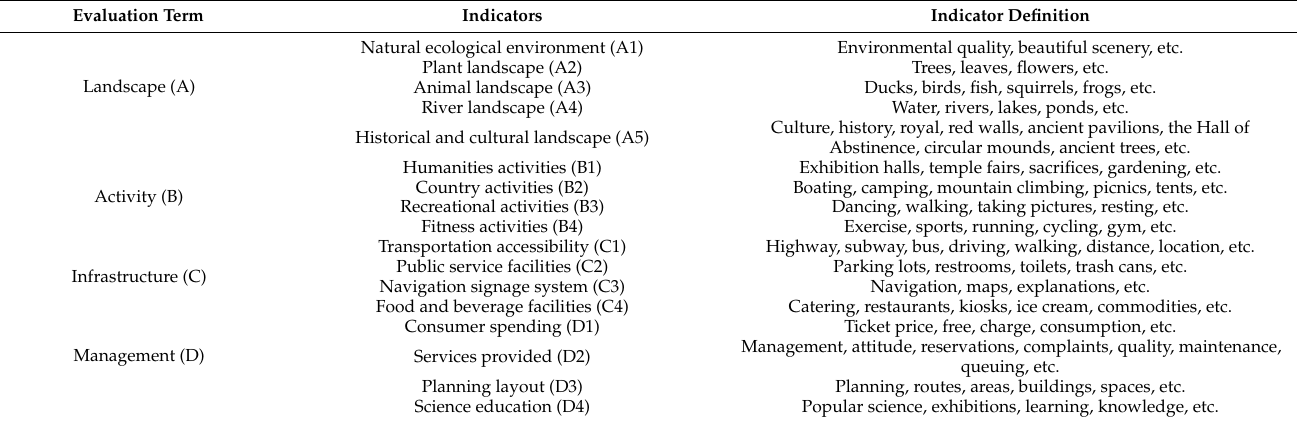
Table 1. Evaluation index system of landscape design.